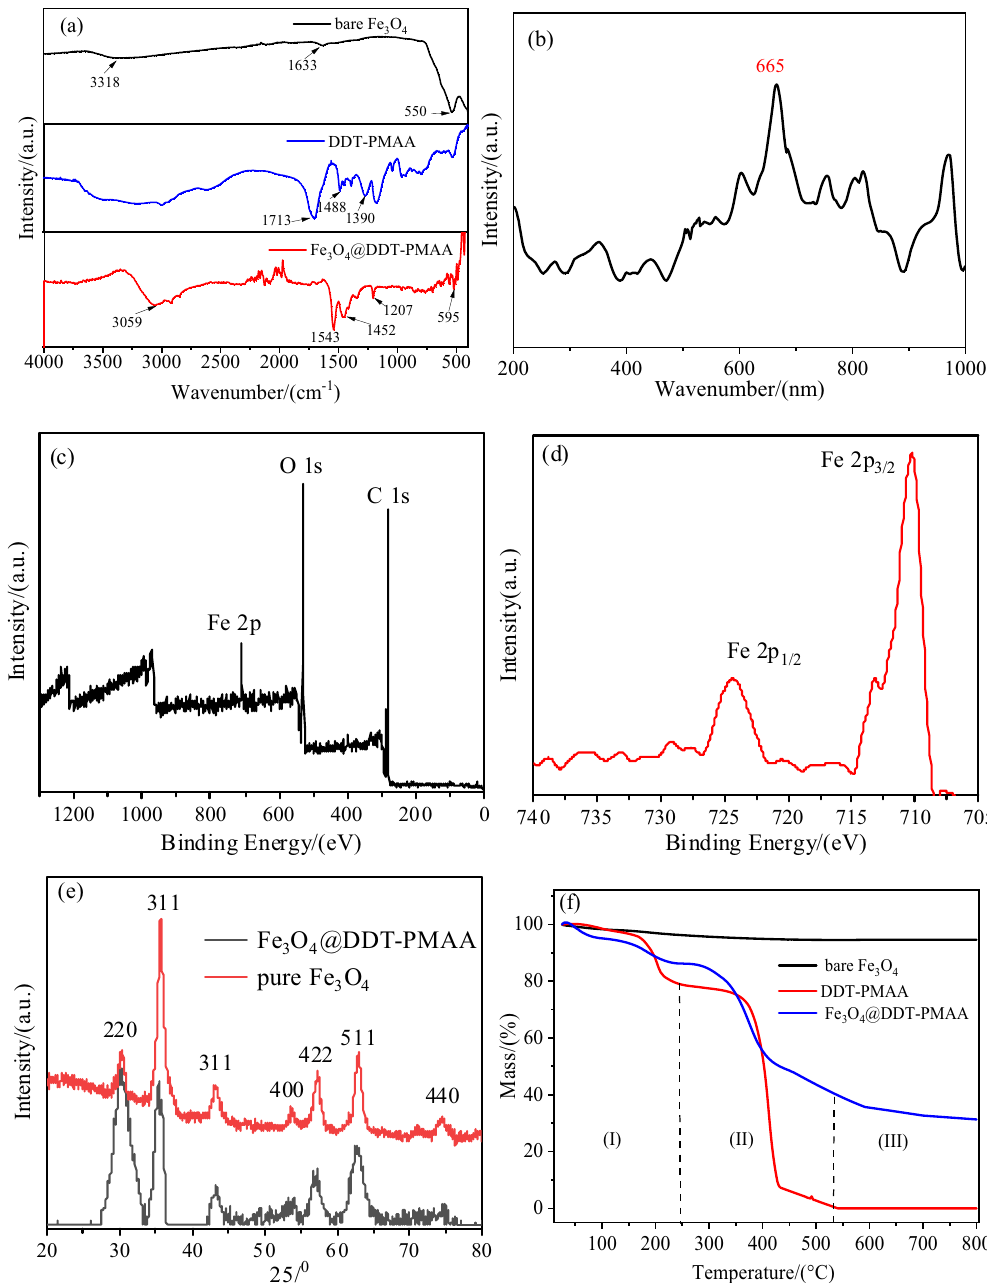
Figure 3: Di ff erent characterizations for Fe 3 O 4 @DDT - PMAA MFs, ( a ) FTIR spectra of bare Fe 3 O 4 , DDT - PMAA, and Fe 3 O 4 @DDT - PMAA; ( b ) Raman spectra of Fe - PMAA NPs under N ( c and d ) XPS survey spectrum of Fe - PMAA; ( e ) TGA curves 3 O 4 @DDT 2 protection; 3 O 4 @DDT of DDT - PMAA, bare Fe 3 O 4 , and Fe 3 O 4 @DDT - PMAA magnetic NPs under N 2 protection; and ( f ) XRD for bare Fe 3 O 4 and Fe 3 O 4 @DDT -